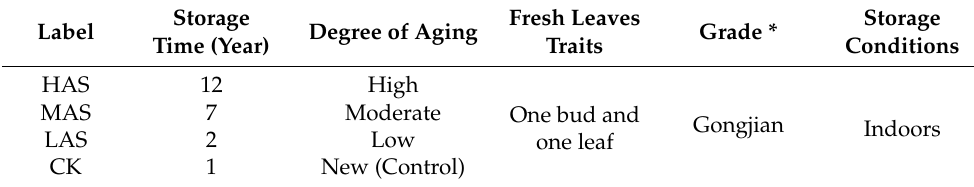
Table 1. Information on An–tea samples.